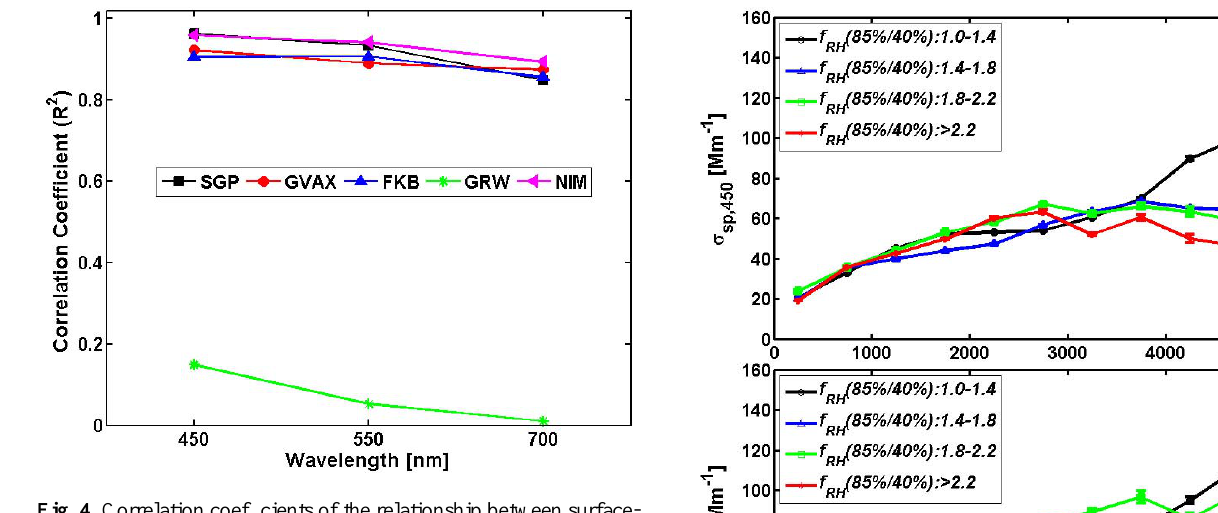
Fig. 4. Correlation coefficients of the relationship between surface- measured aerosol scattering coefficients and CCN 0 . 4 concentrations as a function of wavelength for ambient RH conditions and with aerosol particle diameters of less than 1µm.